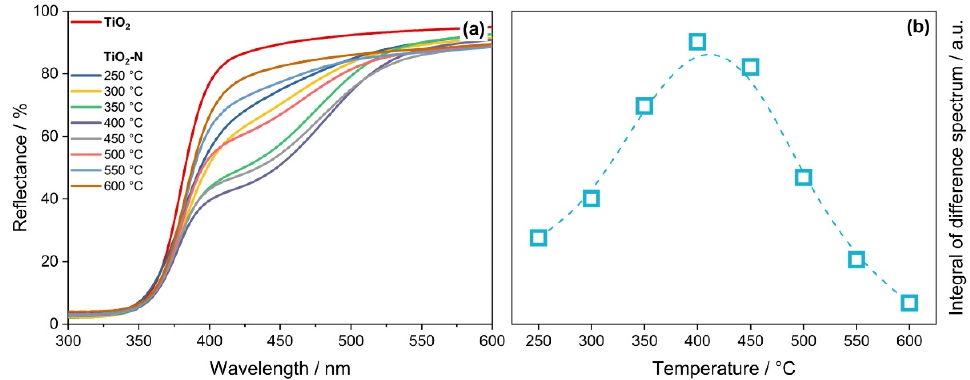
Figure 3. Effect of the calcination temperature on UV–vis DRS spectra of TiO 2 -N ( a ) and integral of the difference spectrum between TiO 2 -N and TiO 2 in the region of 380–550 nm ( b ).